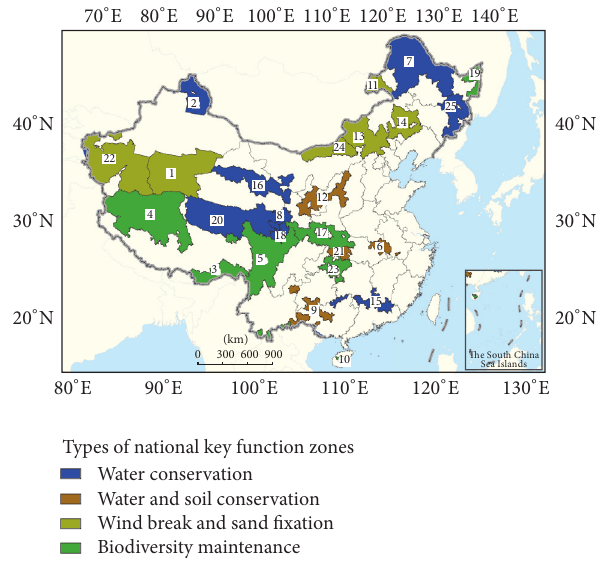
Figure 1: Distribution and location of national key ecological function zones: 1: grassland desertification control region in Arkin (GA);2:mountainforeststepperegioninAltai(MA);3:forestregion in the edge of southeastern Tibet (FT); 4: desert region of Qiangtong Plateau in the northwestern Tibet (DT); 5: forest and biodiversity in Sichuan and Yunnan (FY); 6: soil and water conservation region in Dabie Mountain (SM); 7: forest region in greater and lesser Hinggan Mountains (FM); 8: important water supply region of the Yellow River in Gannan (IG); 9: karst rocky desertification region in Guangxi, Guizhou, and Yunnan (KY); 10: tropical rainforest region of central Hainan Island (TI); 11: grassland meadow region in Hulun Buir (GB); 12: hilly and gully region of Loess Plateau (HP); 13: Hunshandake desertification region (HD); 14: grassland desert region of Horqin (GH); 15: forest and biodiversity region in Nanling Mountain (FNM); 16: glacier and water conservation region in Qilian Mountain (GM); 17: biodiversity region in Qinba (BQ); 18: grassland wetland region of Ruoergai (GR); 19: wetland region of Sanjiang plain (WS); 20: grassland meadow wetland region in Sanjiangyuan (GS); 21: Three Gorges Reservoir Area (TA); 22: desertification control region of Tarim River (DR); 23: biodiversity, soil conservation region in Wuling Mountains (BW); 24: grassland region in Yinshan Mountain (GYM); 25: forest region in Changbai Mountain